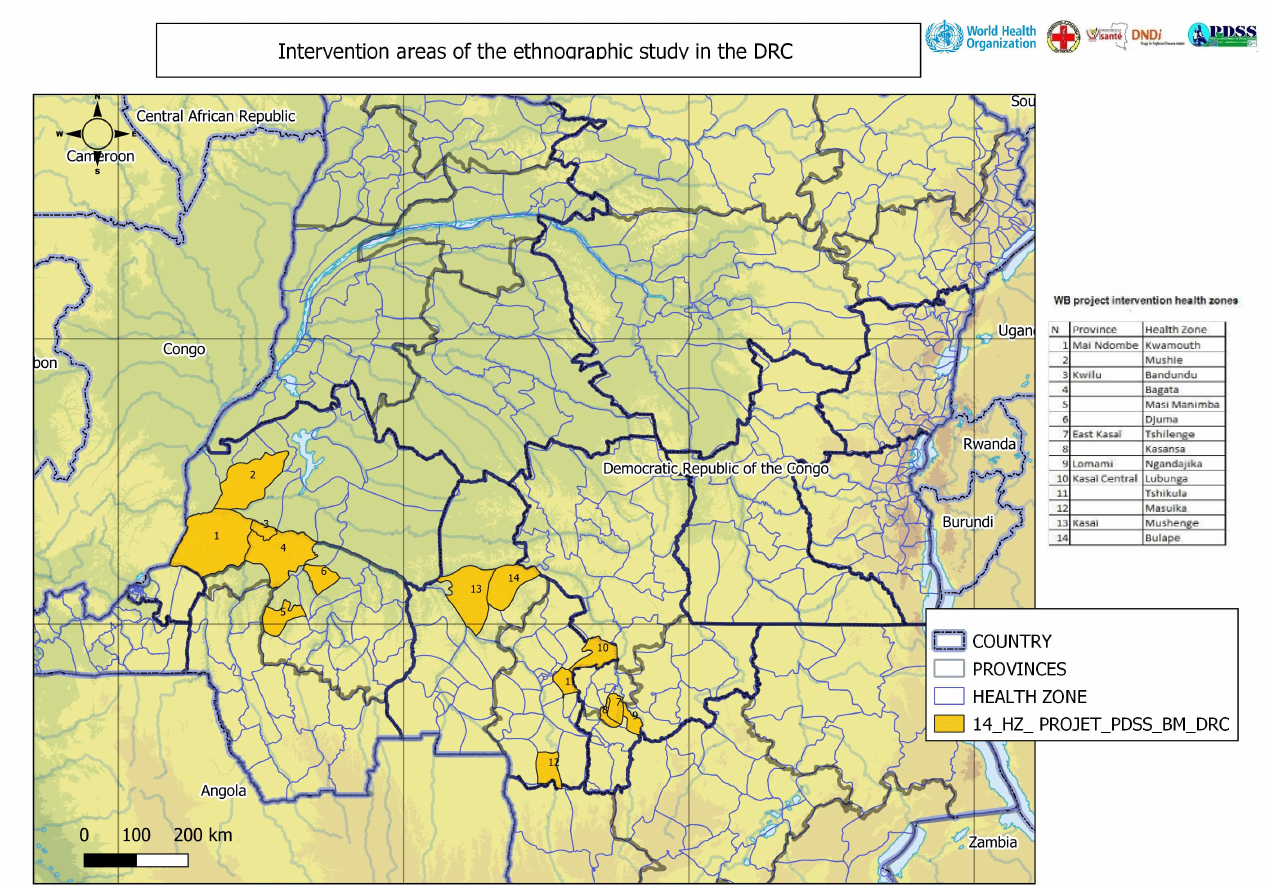
Figure 2. Map of the health zones studied. (Source = PNLTHA